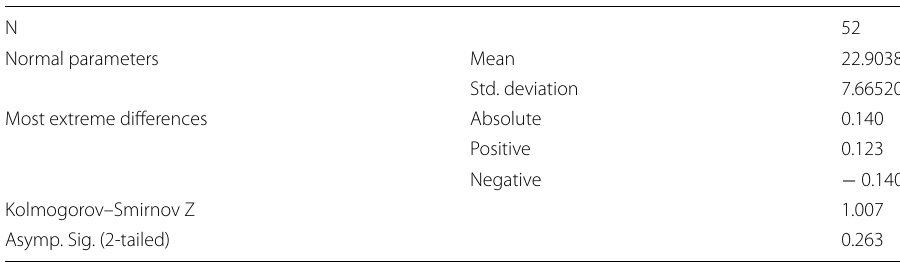
Table 1 Kolmogorov–Smirnov test (experimental group) N 52 Normal parameters Mean 22.9038 Std. deviation 7.66520 Most extreme differences Absolute 0.140 Positive 0.123 Negative 0.140 − Kolmogorov–Smirnov Z 1.007 Asymp. Sig. (2‑tailed)